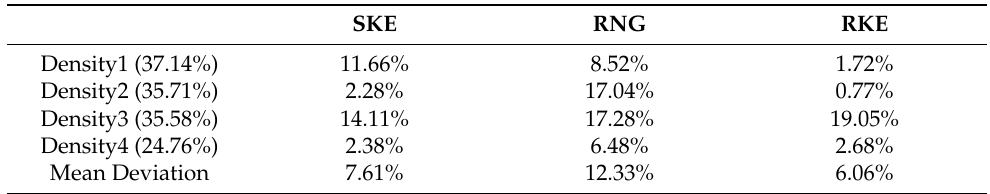
Table 3. The deviation between the measured and simulated turbulence intensity for different building